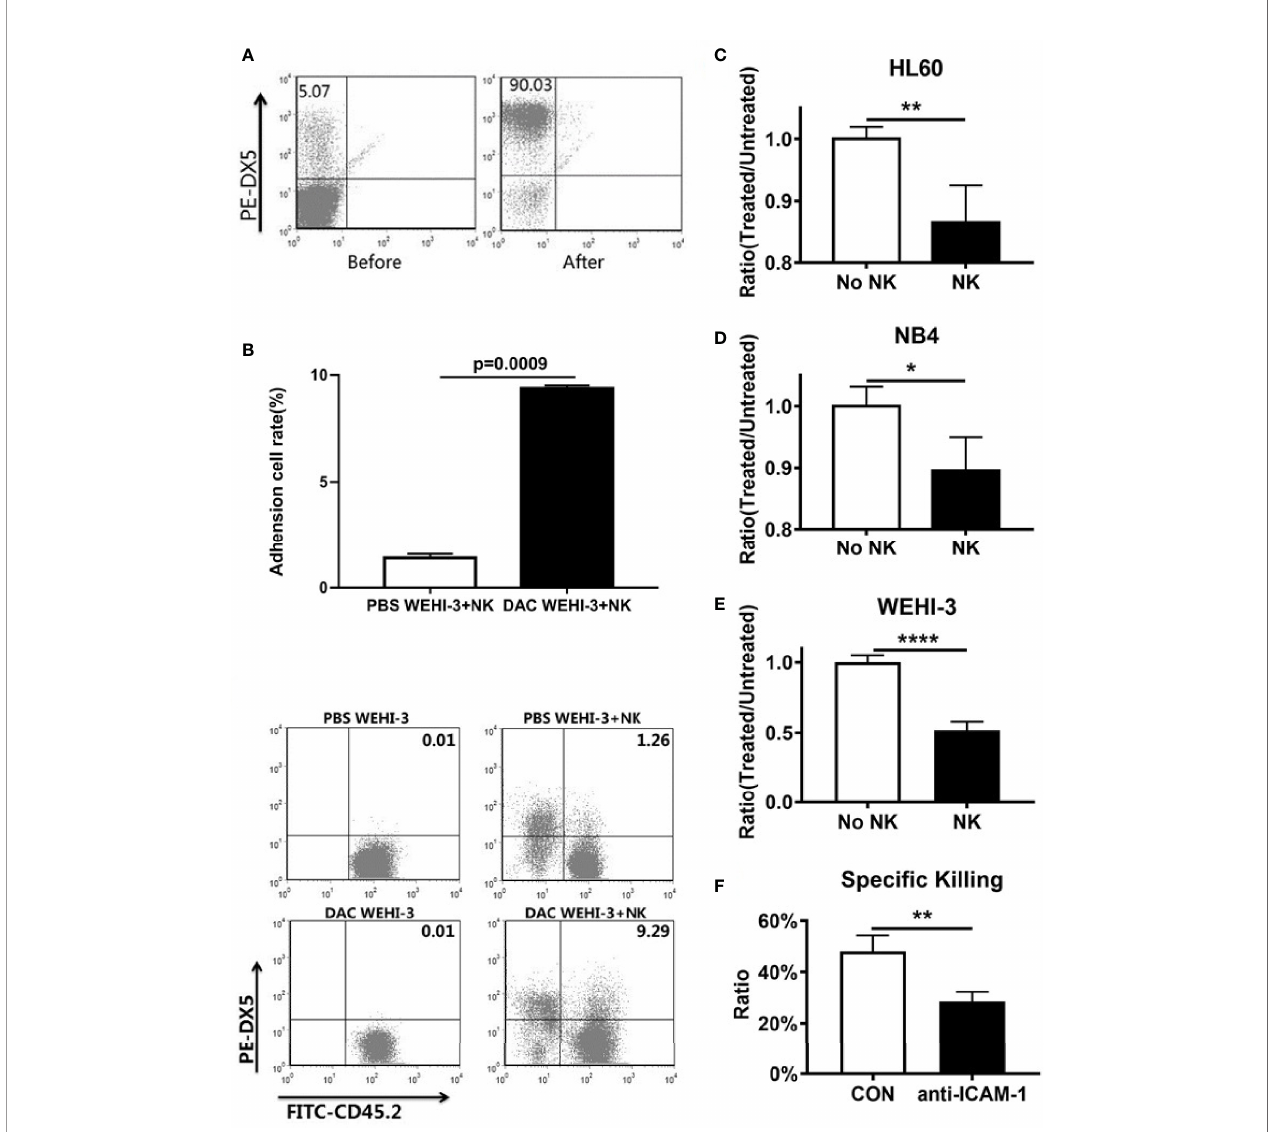
FIGURE 2 | ICAM-1 expression and NK killing rate increased by hypomethylating in vitro . (A) Purity of NK cells before and after magnetic bead sorting. (B) The adhesion between NK cells and DAC WEHI-3 cells was signi fi cantly enhanced (mean ± SD, n=3, repeat three times). DAC enhanced NK cells ’ sensitivity to (C) NB4, (D) HL60, and (E) WEHI-3, cells (mean ± SD, n=4). (F) The NK cell killing rate of decitabine treated or untreated with WEHI-3 cells, and then co-cultured with NK cells with or without the ICAM-1 antibody to block ICAM-1 for 24h (mean ± SD, n=4). *p < 0.05, **p < 0.01, ****p <